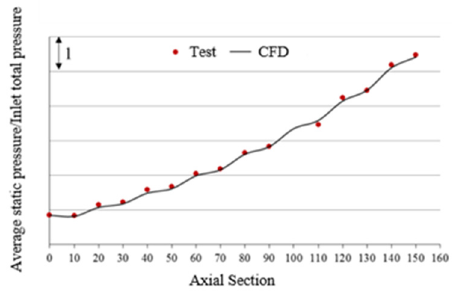
Figure 6. Static pressure distribution between blade rows.